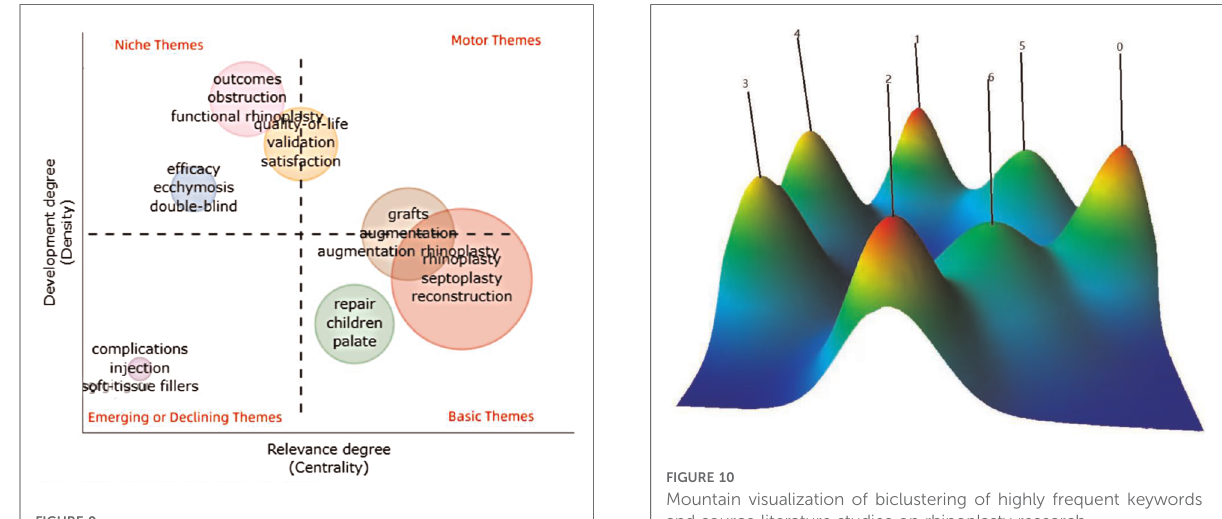
FIGURE 9 The thematic map of keywords plus.